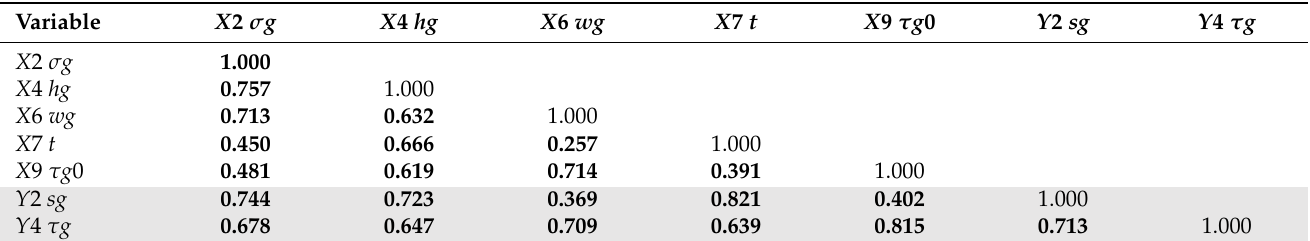
Table 4. Matrix of linear simple correlation coefficients r for